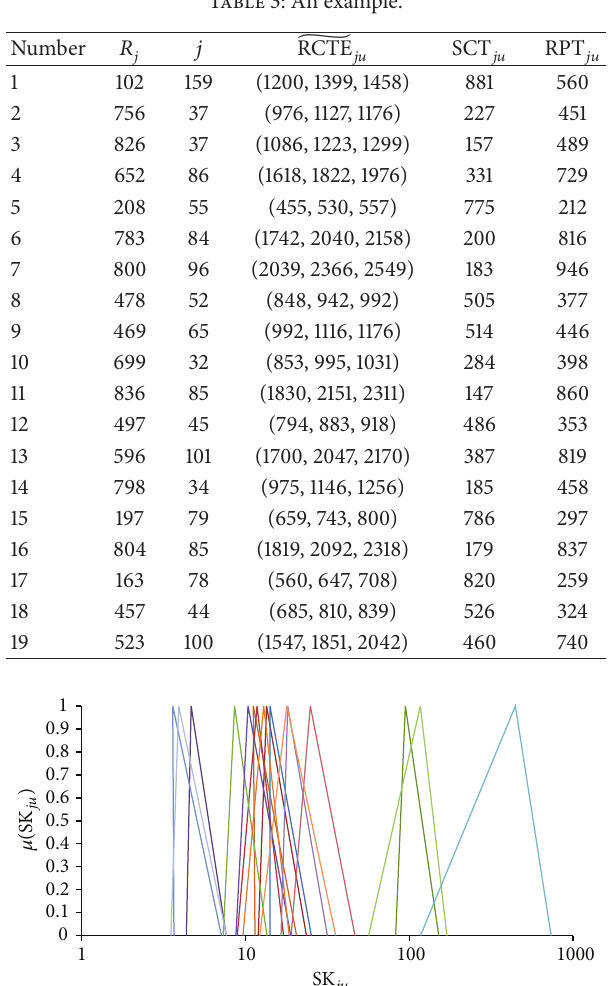
Figure 4: The fuzzy slacks obtained by the proposed